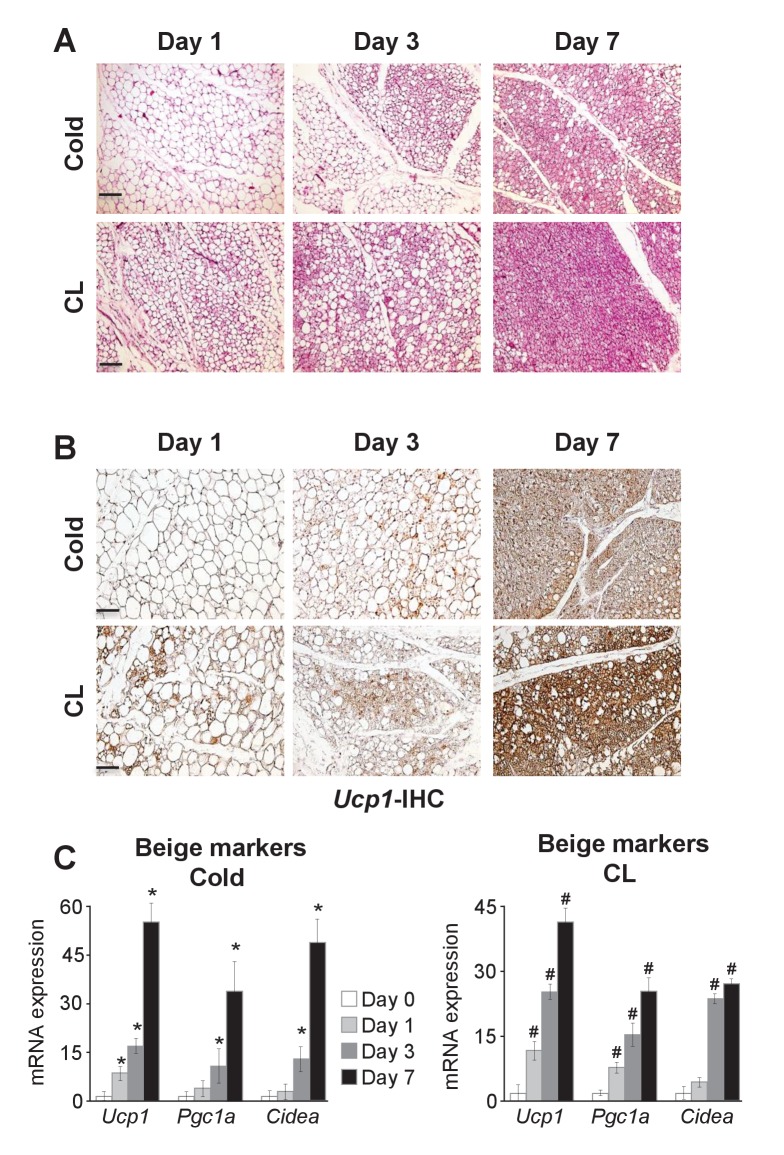
Differences between cold exposure and Adrb3 agonists induced beiging.(A) Representative H&E staining of IGW depot sections from two-month-old male mice cold exposed (6.5°C) or treated with CL (1 mg/Kg/mouse/day) for one, three or seven days (n= 6/group) (lower magnification images). Scale bar = 100 µm. (B) Representative Ucp1 IHC staining of IGW depot sections from mice described in (A) (n= 6/group). Scale bar = 100 µm. (C) mRNA expression of denoted genes from IGW depots from mice described in (A) cold exposed (right) or treated with CL (left) for zero, one, three, or seven days (n= 6/group in triplicate). #p<0.002 unpaired t-test, two tailed: days of CL treatment compared to Day 0 (no treatment). *p<0.001 unpaired t-test, two tailed: days of cold exposure compared to Day 0 (no cold).